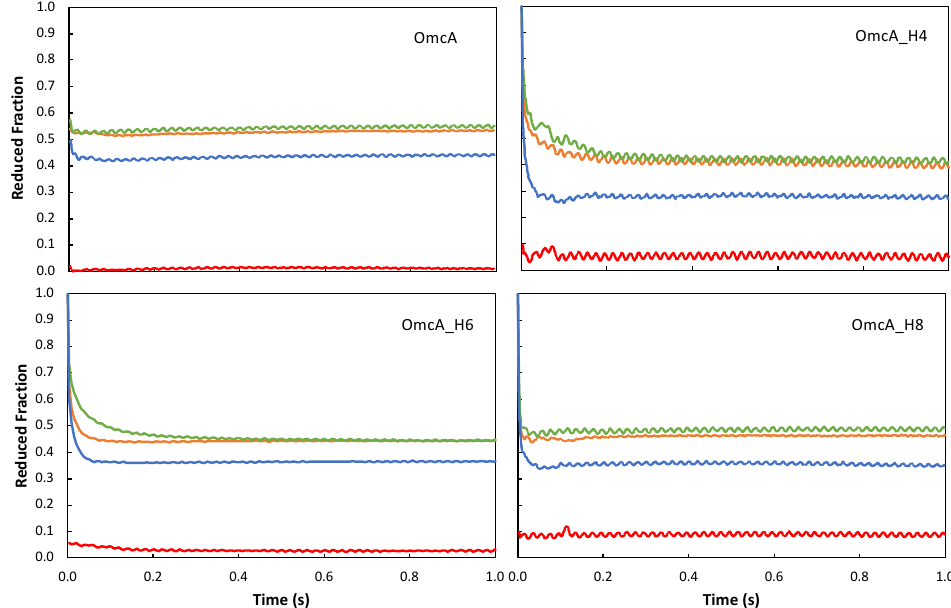
Figure 3. Kinetic traces of oxidation of native OmcA (from [29]) and mutants OmcA_H4, OmcA_H6, and OmcA_H8, by RF (orange), FMN (green), AQDS (blue), and PMS (red). The cytochrome concentration was 0.5 µ M, 1.3 µ M, and 0.6 µ M for mutants OmcA_H4, OmcA_H6, and OmcA_H8, respectively.